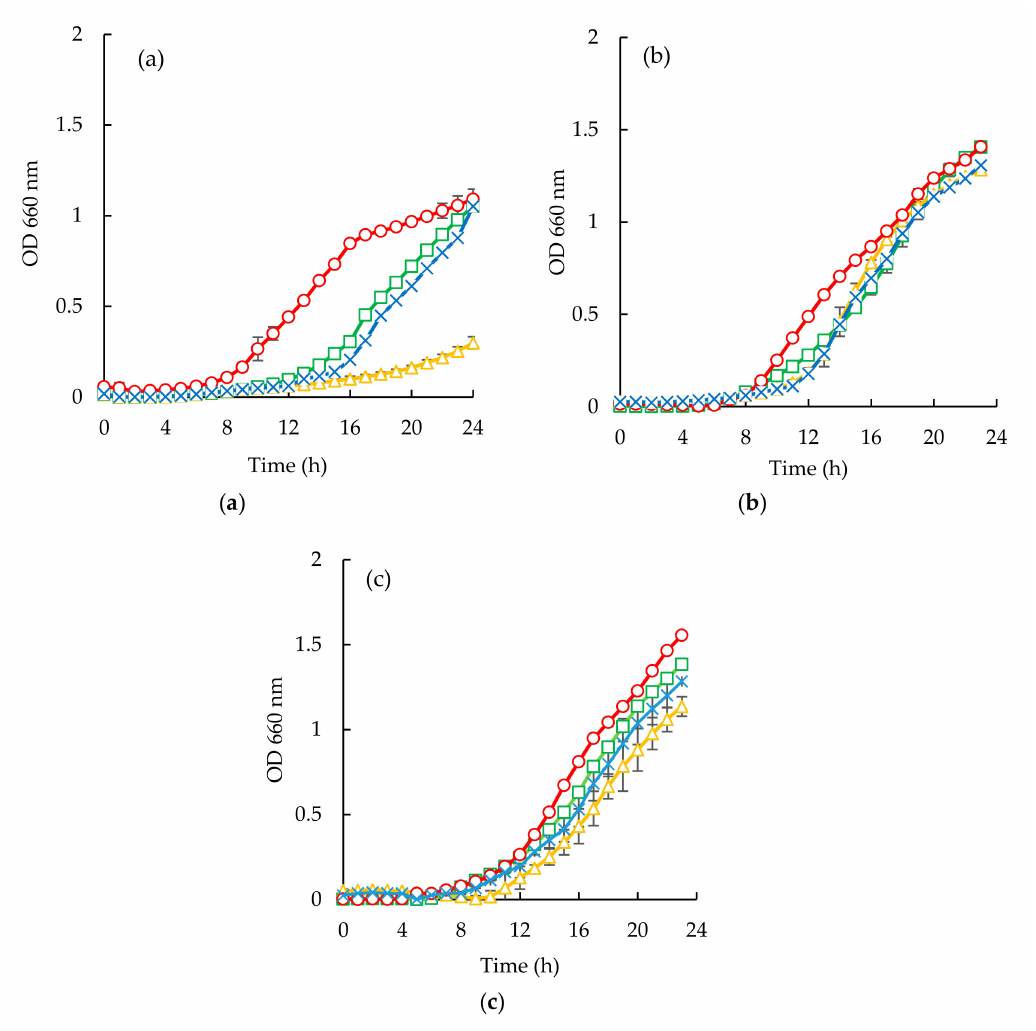
Figure 7. Time inhibition curves drawn with permeates obtained from sardine cooking wastewaters ( , positive control; (cid:3) , cooking wastewater; ∆ , GE Suez GH (1.0 bar); x, GE Suez GH (5.0 bar) for E. coli (cid:35) (a), S. aureus (b), C. albicans